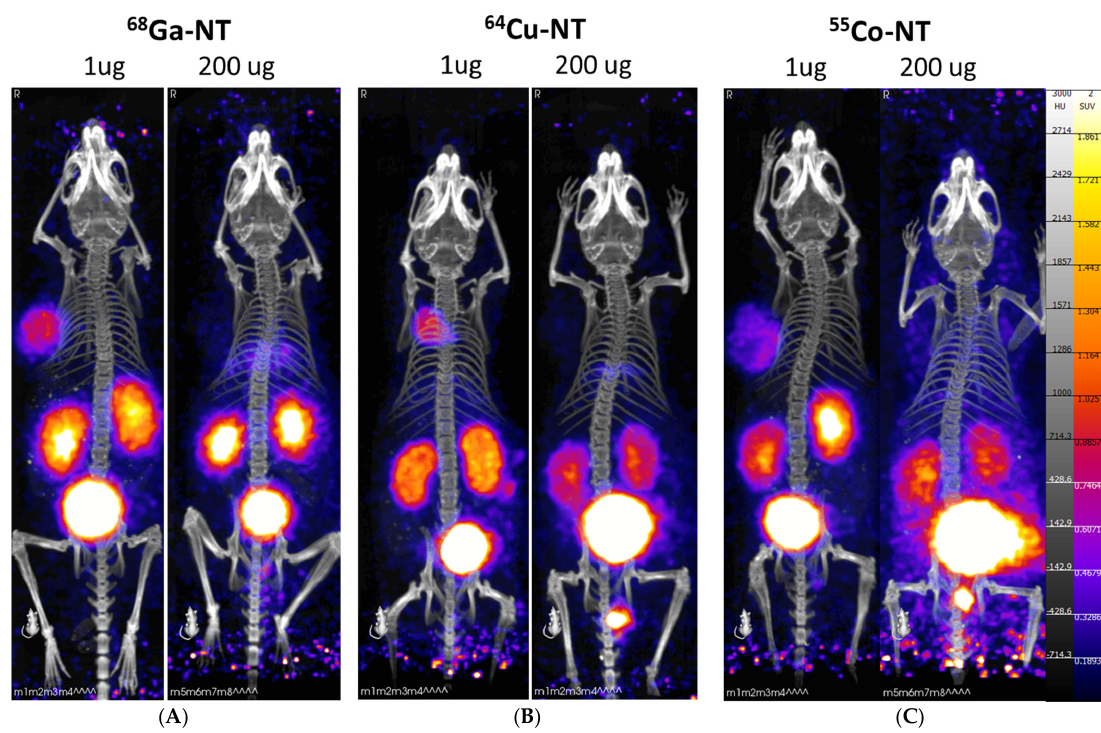
Figure 3. PET/CT imaging 1 h post-injection with radiolabeled NOTA-NT-20.3 in mice bearing HT29 tumor xenografts. Mice were imaged with [ 68 Ga] Ga-NOTA-NT-20.3 ( A ), [ 64 Cu] Cu-NOTA-NT-20.3 ( B ), and [ 55 Co] Co-NOTA-NT-20.3 ( C ). At the 4 h PI timepoint, images show sustained tumor uptake and additional wash- out of the radiolabeled peptide from non-target organs (Figure 4). At this timepoint, dif- ferences between imaging agents were apparent. In the mice injected with [ 64 Cu] Cu- NOTA-NT-20.3, liver uptake was observed in the 1 μ g injection group. Most likely, this was the result of the release of free copper-64 from the imaging agent, which was known to be sequestered by the liver [30]. Interestingly, this was observed less in the blocking group, as both liver and kidney accumulation were reduced as compared to the low dose group. Imaging with [ 55 Co] Co-NOTA-NT-20.3 showed significant tumor uptake in the 1 μ g injection group, which was not observed in the high-mass (blocking) group. Similarly to [ 64 Cu] Cu-NOTA-NT-20.3, there was reduced kidney uptake in the 200 μ g injection group.